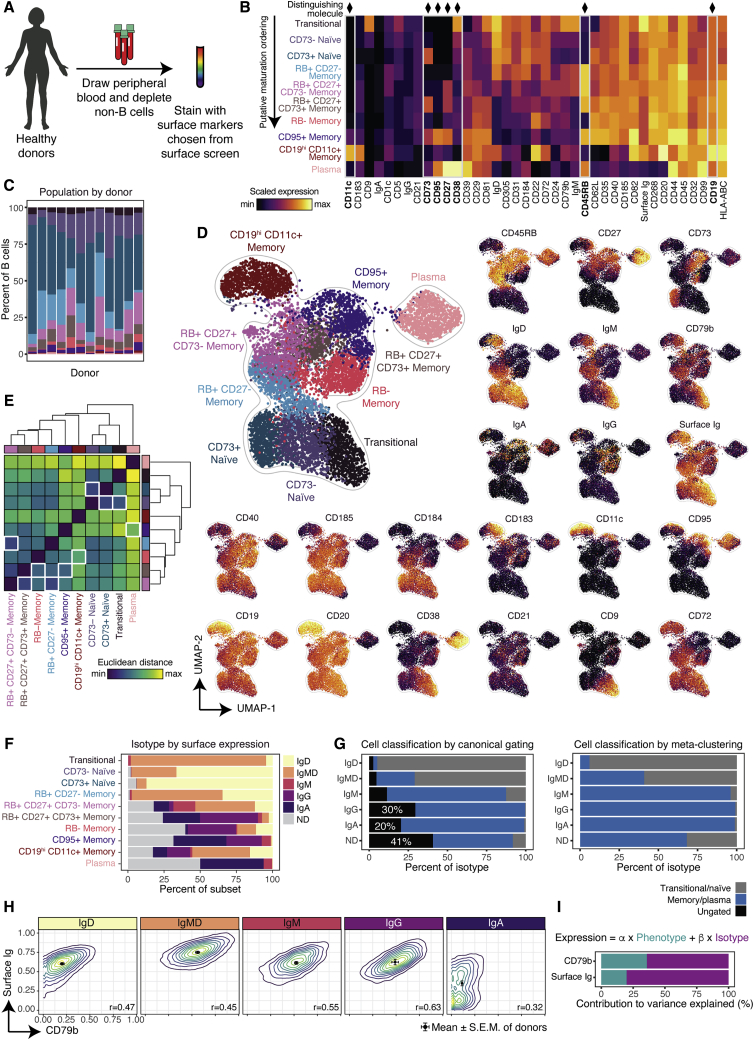
Segregating B cells into phenotypically and isotypically distinct subsets(A) Experimental workflow (n = 3 donors).(B) Median expression by subset.(C) Percent of B cells for all subsets, colored as in (B).(D) UMAP plot generated from an equal subsampling by subset.(E) IgH isotype usage by subset. ND denotes “not determined”; IgMD denotes co-expression of IgM and IgD.(F) Euclidean distance between each B cell subset based on median expression profile. White boxes denote column minimum.(G) Subset composition by isotype as determined by canonical gating or meta-clustering.(H) Contour plots by IgH isotype. Dots and error bars indicate mean and SEM of individual donors.(I) Relative contribution of phenotype and isotype to the variance explained by linear models created to predict single-cell expression of CD79b or surface Ig.